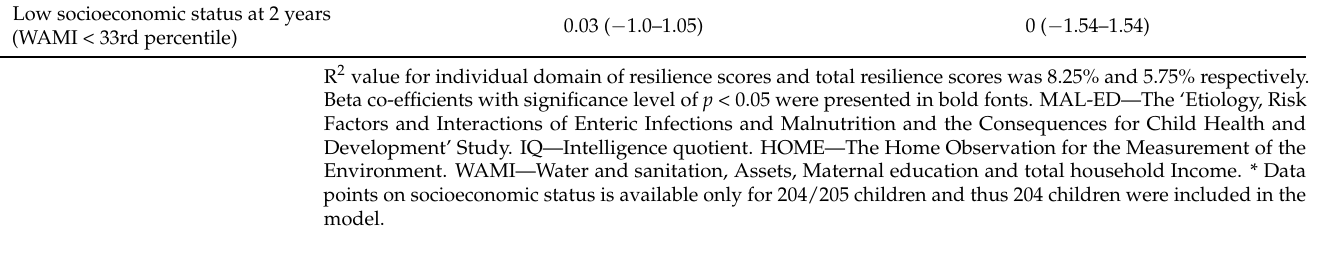
Table 4. Multivariate analysis of specific domains of resilience scores with domains of HOME in children of MAL-ED cohort ( n = 204